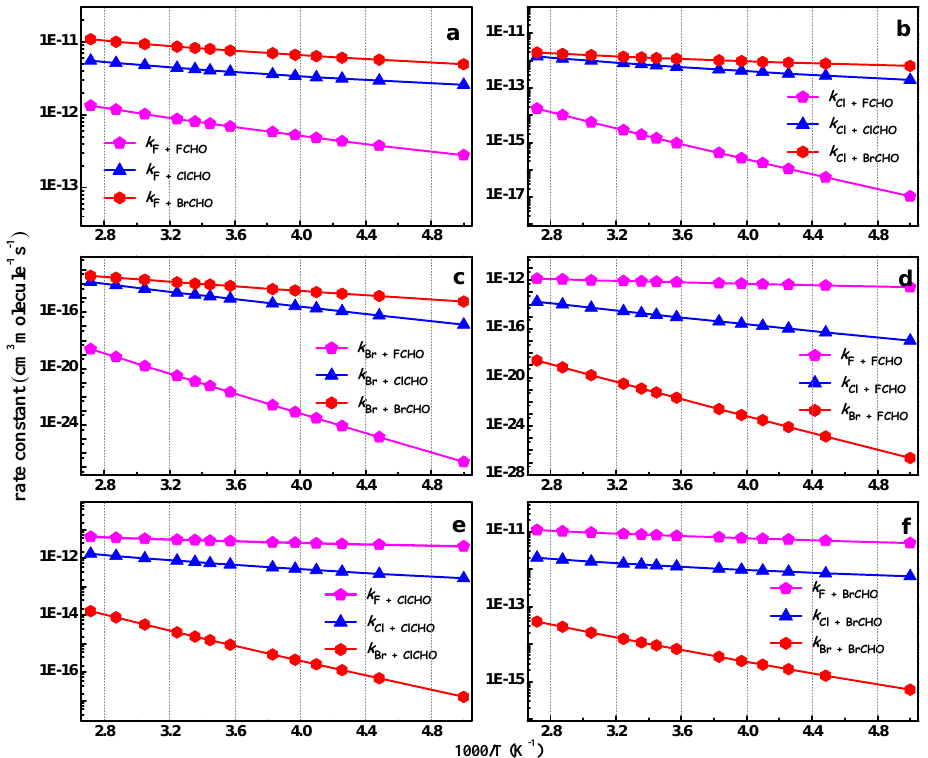
Fig. 2. Plot of the CVT/SCT rate constants versus 1000/T within the temperature range of 200–368K for the reactions of (a) F+QCHO, (b) Cl+QCHO, (c) Br+QCHO, (d) X+FCHO, (e) X+ClCHO, and (f) X+BrCHO. Herewith, X and Q are F, Cl, Br atoms.